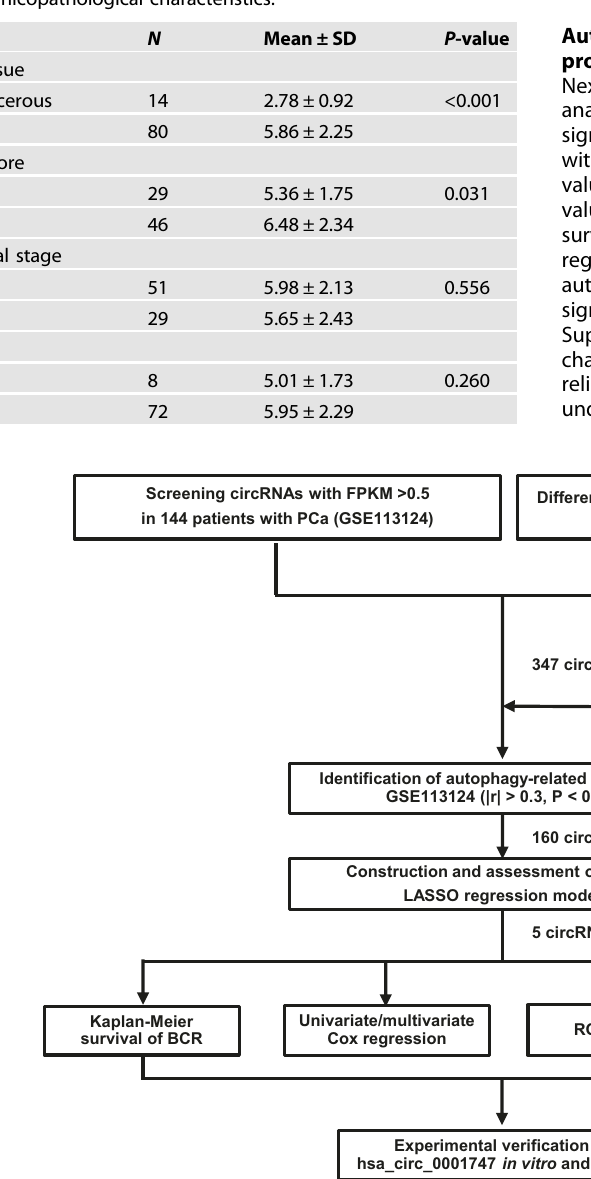
Table 1. Correlation between MAP1LC3B protein expression level and patients clinicopathological characteristics.